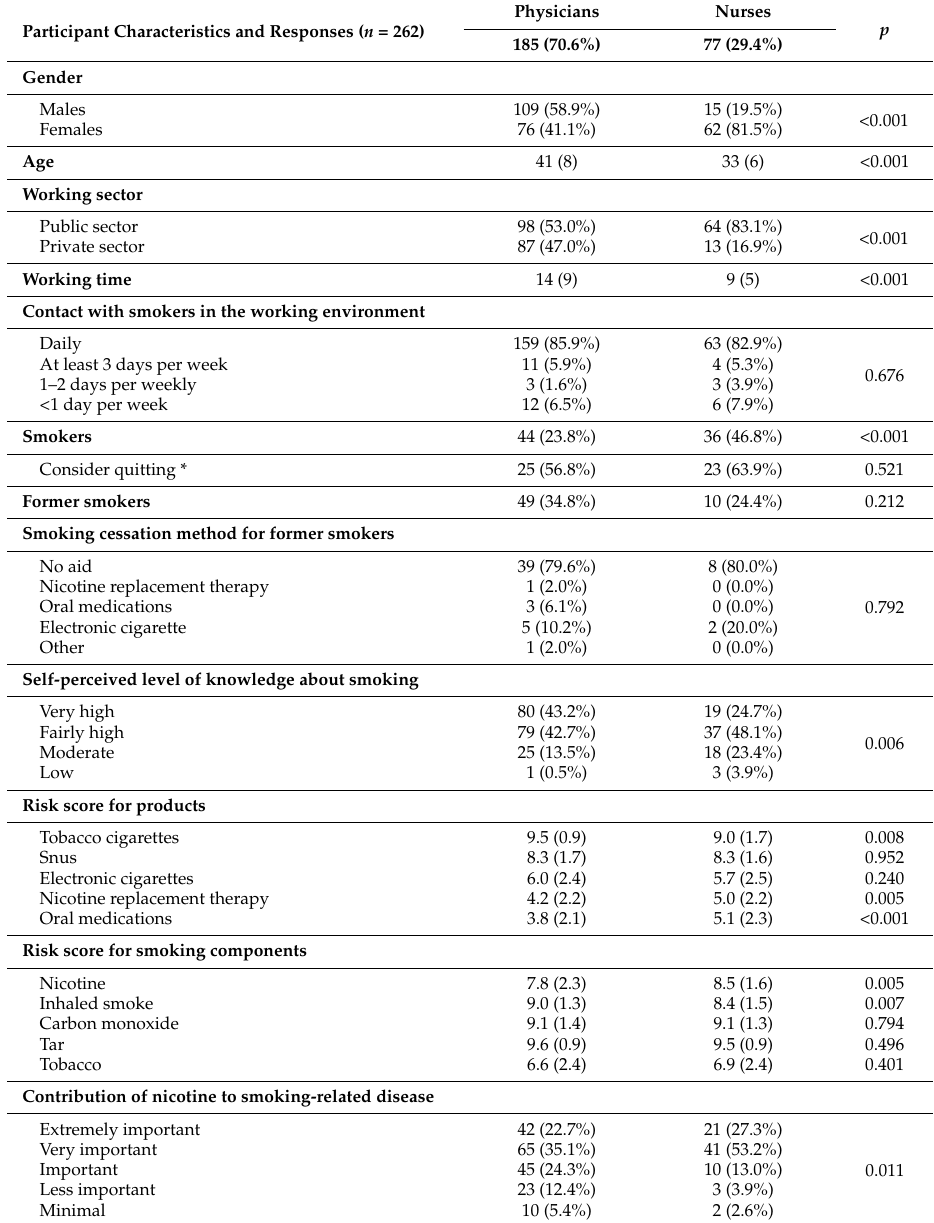
Table 3. Comparison of survey responses between physicians and